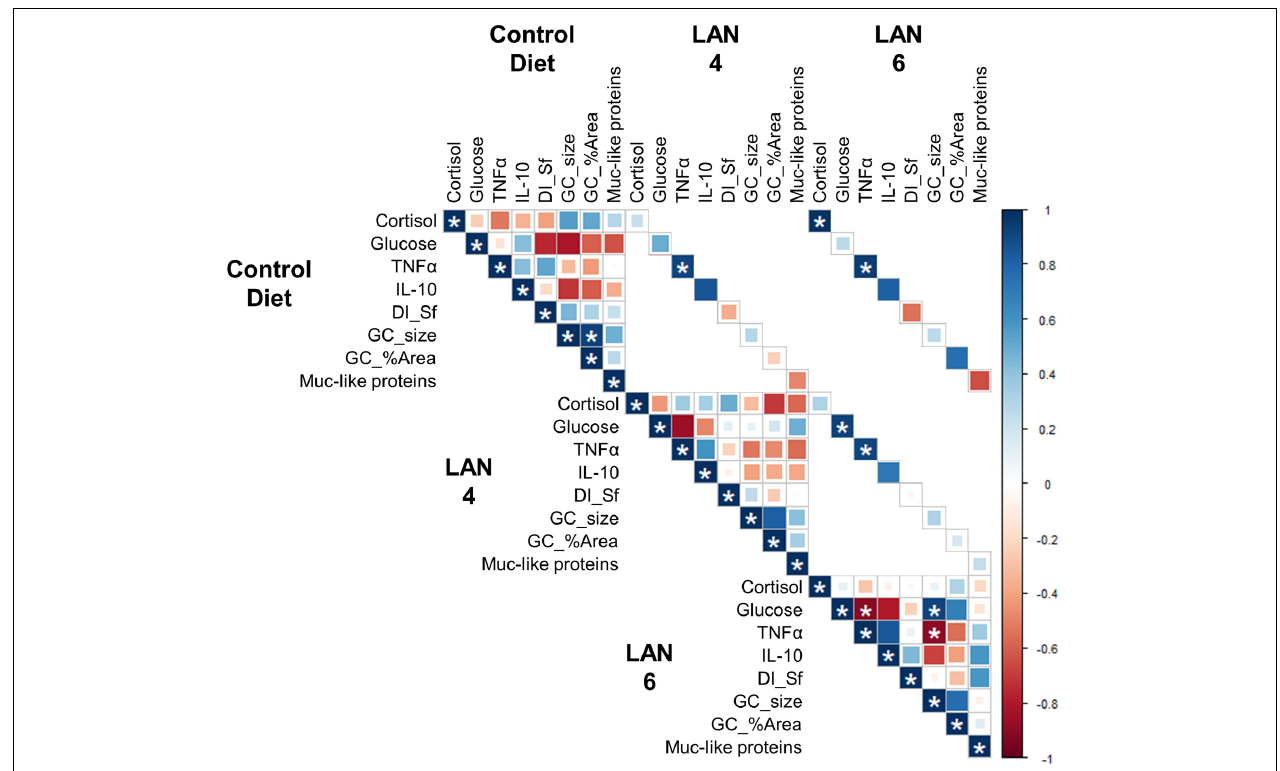
FIGURE 4 | Correlation analysis among the different parameters (cortisol, glucose, TNF α , IL-10, DI simple folds, goblet cells size, goblet cells area, and Muc-like proteins). All the parameters that are significantly correlated ( p < 0.01) are denoted by *. Degrees of freedom = 6. In blue: positive correlation. In red: negative correlation.